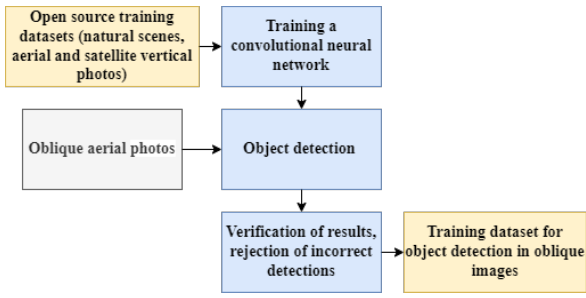
Figure 8. Flowchart of the methodology for creating a dataset for object detection in oblique